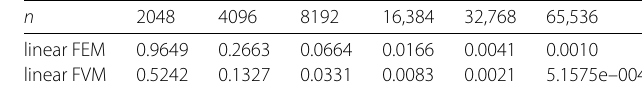
Table 6 The error in the relative discrete H 1 -seminorm for problem (5.1) with k = 500 n